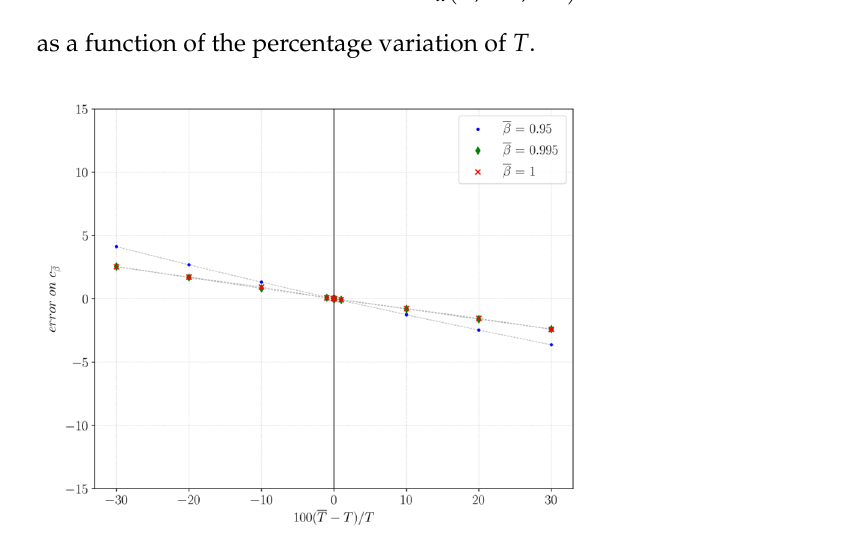
Figure 8. Percentage variation of the normalized energy cost for λ = 1/1800 s − 1 , β = 0.95 (circles), 𝛽̅ = 0.995 (diamonds), 𝛽̅ = 1 (crosses).